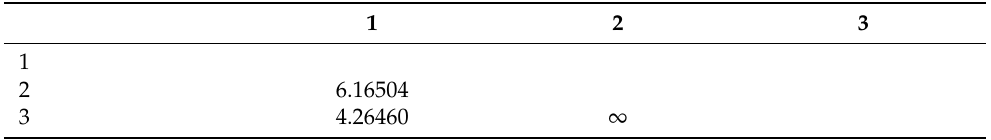
Figure 3. UPGMA tree of three populations, distance method: number of different FST alleles. Table 7. Gene flow: matrix of M-values (M = 2 Nm).